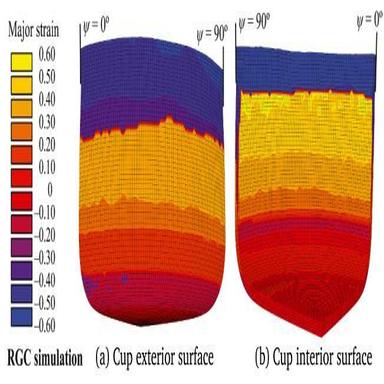
Distribution of major strain resulting from the deep drawing process. Figure adopted from with permission from IOP Publishing.